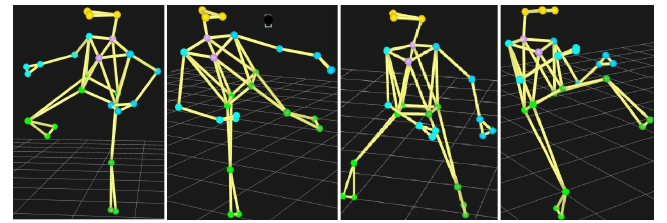
Fig. 1. Examples of postures from kata Heian Yondan (MoCap data)